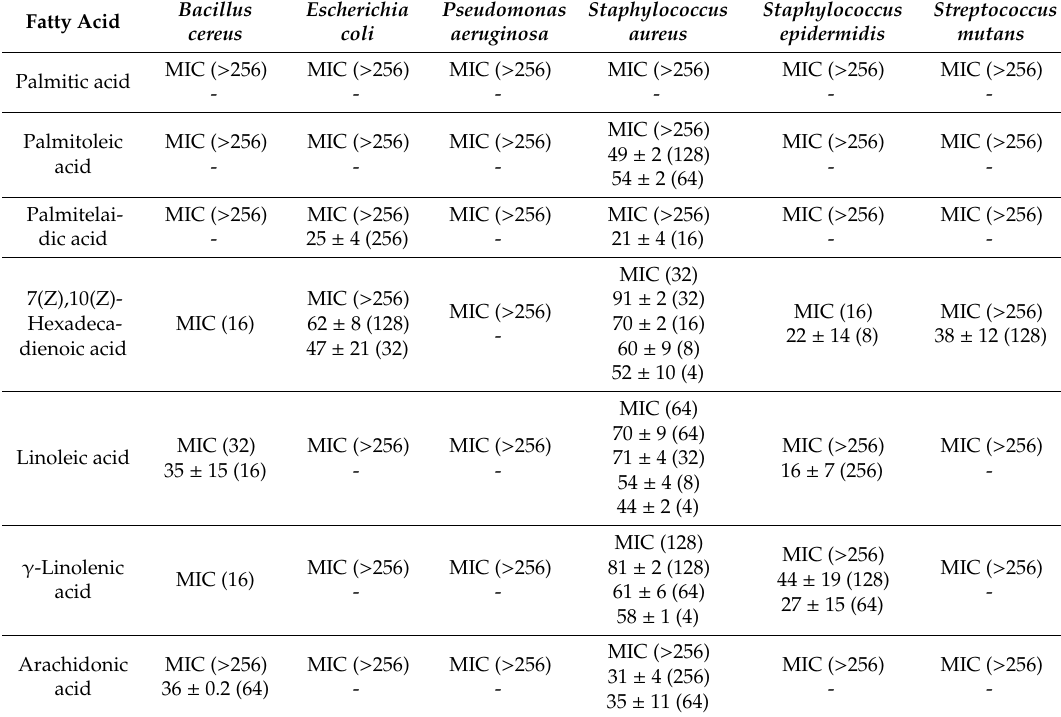
Table 1. Minimal inhibition concentrations (MIC) and biofilm inhibitions (% compared to the negative control) of the tested fatty acids against several bacteria. No inhibitions at sub-MIC concentrations were found for Pseudomonas aeruginosa . Fatty acid concentrations in brackets ( µ g mL − 1